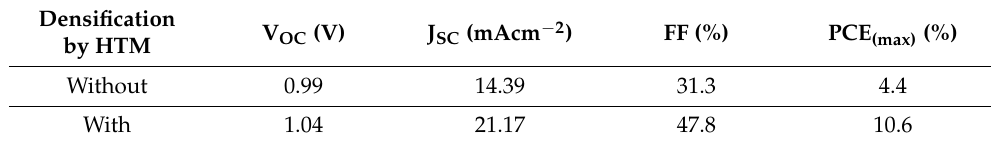
Table 6. J-V parameters of the carbon-based devices fabricated by spiro-OMeTAD. The record effi- ciency in the backward scan direction is marked with PCE max .